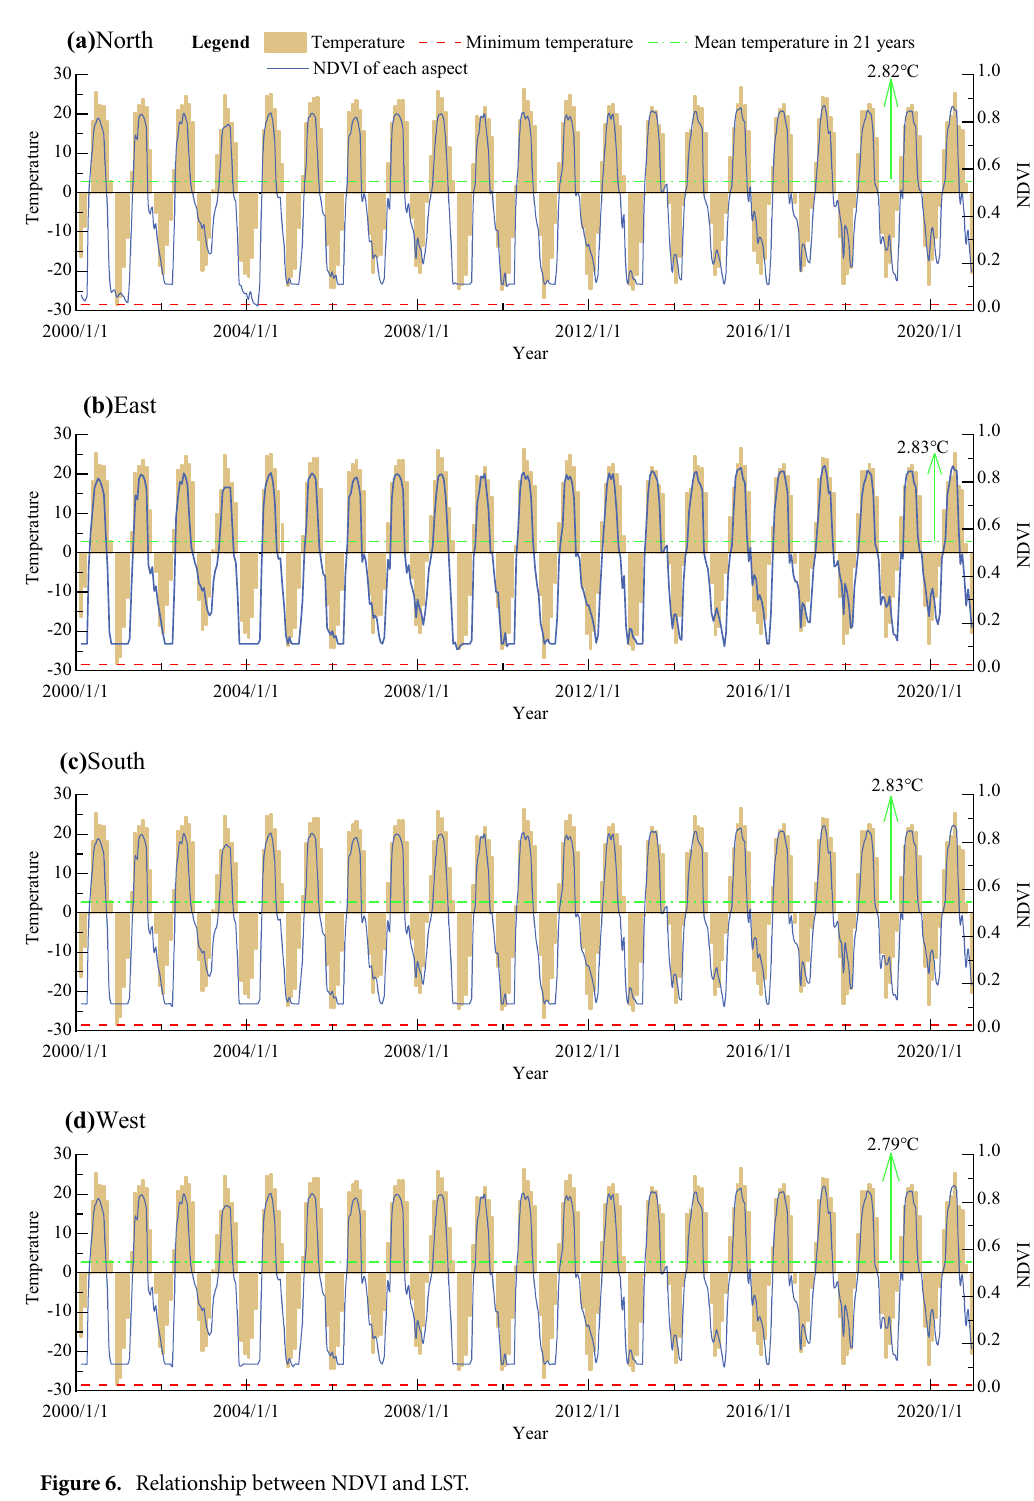
Figure 6. Relationship between NDVI and